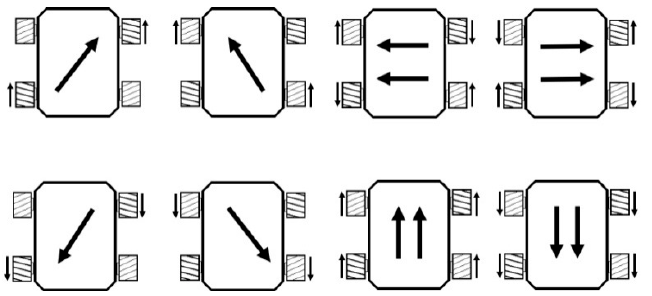
Figure 2. The eight main motion modes of the omnidirectional wheel vehicle.